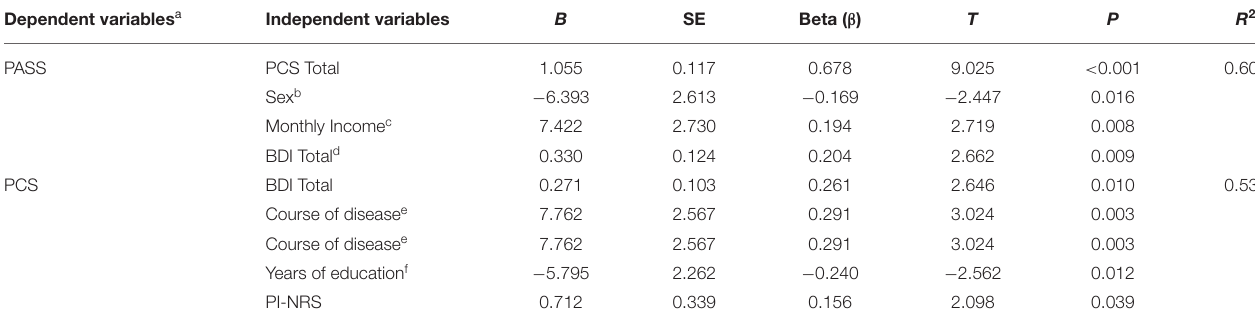
TABLE 5 | Prediction of risk factors by regression analysis. Dependent variables a